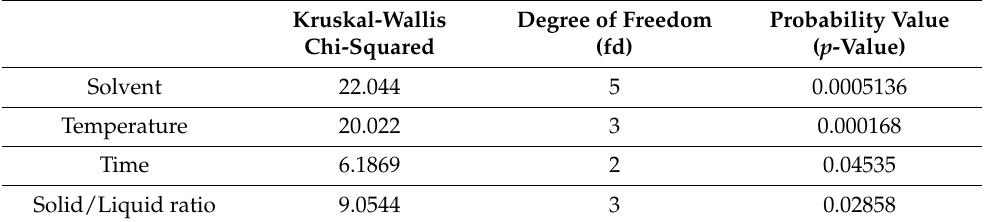
Table 1. Kruskal-Wallis test of influencing parameters during solid/liquid extraction of spent coffee grounds. Kruskal-Wallis Degree of Freedom Probability Value Chi-Squared (fd) ( p -Value) Solvent 22.044